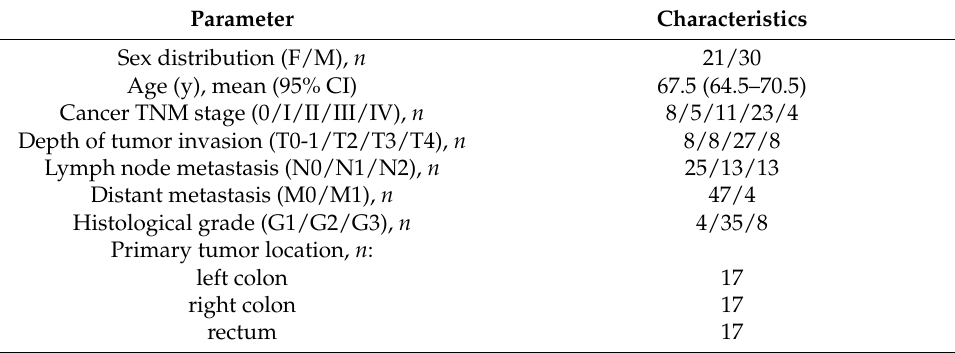
Table 2. Characteristics of patients with colorectal